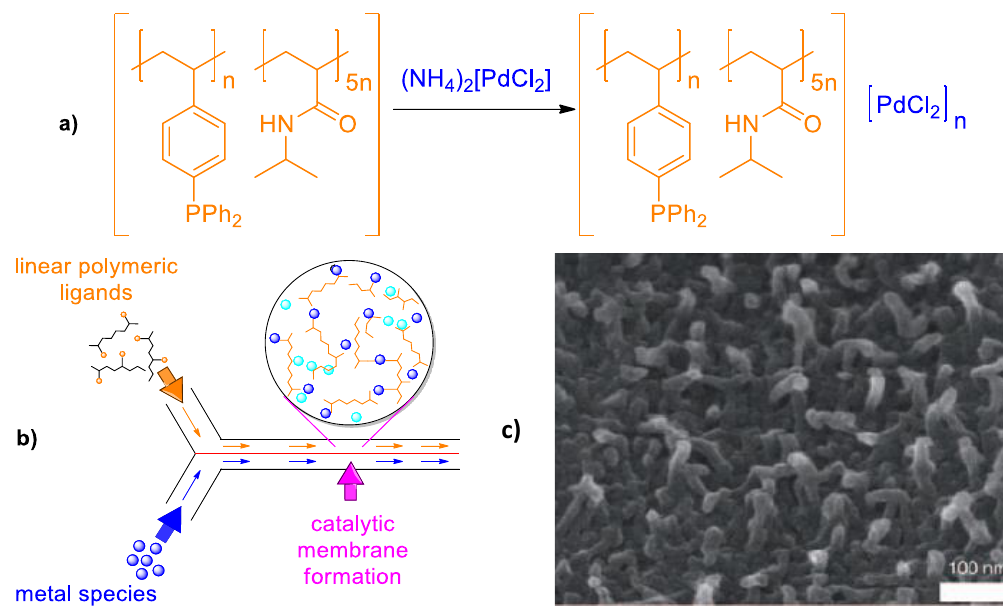
Figure18. Polymer-metalcatalystcomposedofpoly[(N-isopropylacrylamide) 5 - co -(4-diphenylstyrylpho